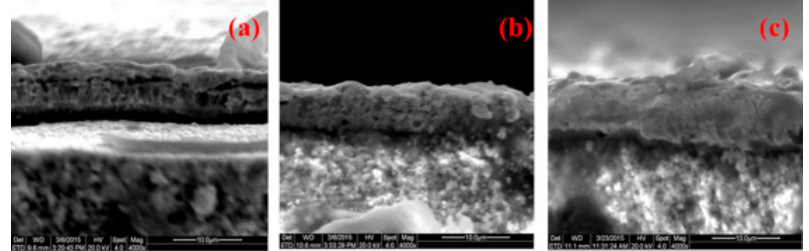
Figure 8. Microstructural modification on Pd films prepared by ELP after different thermal treatments: ( a ) as prepared; ( b ) 168 h at 550 °C; and ( c ) 72 h at 700 °C [42], with permission from © Elsevier.